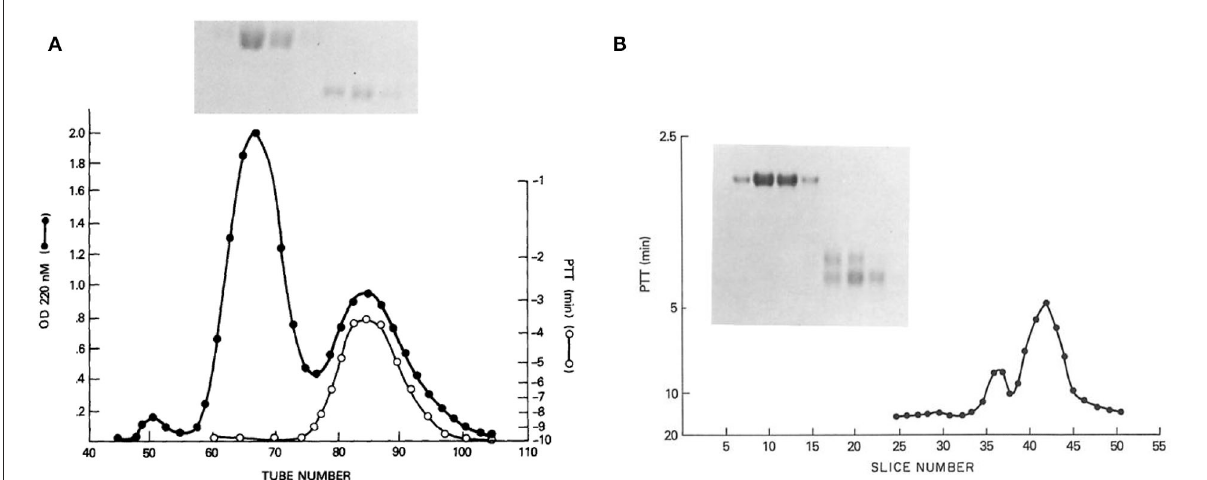
FIGURE1 (A) Sephadex G-200 gel filtration of reduced kinin-free HMW kininogen. The absorbance at 280nm is shown (black line) in addition to the ability of fractions to correct the partial thromboplastin time of HK kininogen-deficient plasma (white line). Above (inset) is shown the SDS-PAGE pattern obtained after electrophoresis of 100 µ l of tubes 60, 65, 70, and 75 (heavy chain), and electrophoresis of 100 µ l of a 10-fold concentration of tubes 80, 85, and 90 (light chain). (B) Urea disc gel electrophoresis of samples taken from the Sephadex G-200 gel filtration of reduced kinin-free HWM kininogen [in this figure (A) ]. A 100 µ l of tubes 60, 65, 70, and 75 followed by 100 µ l of a 20-fold concentration of tubes 80, 85, and 90 were applied. A replicate gel was sliced, each slice was eluted with 0.2ml phosphate-buffered saline, and the eluates